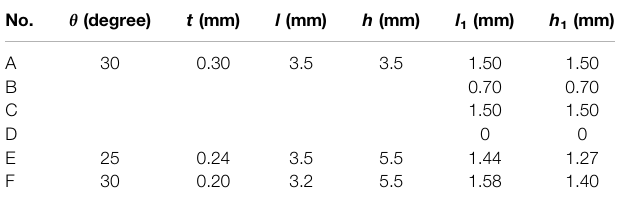
TABLE 1 | Geometric parameters of pentamode cellular structures for the anisotropic-density acoustic waveguide and the anisotropic-modulus acoustic